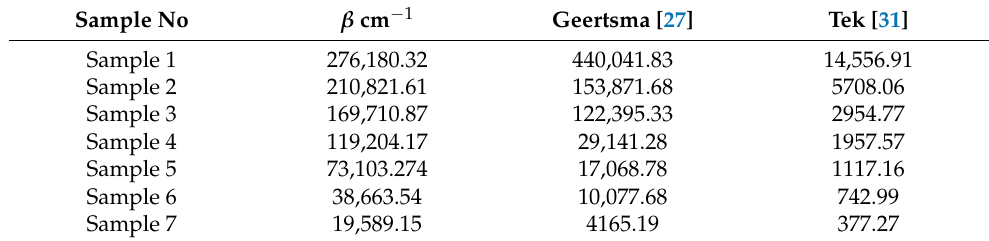
Figure 7. Calculating the non-Darcy β . Permeability = 26 Darcy. Table 3. Calculated values for non-Darcy’s